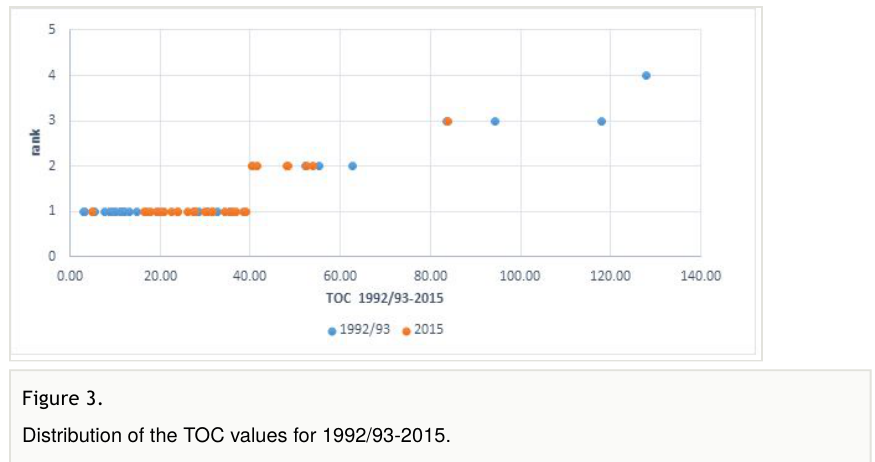
Figure 3. Distribution of the TOC values for